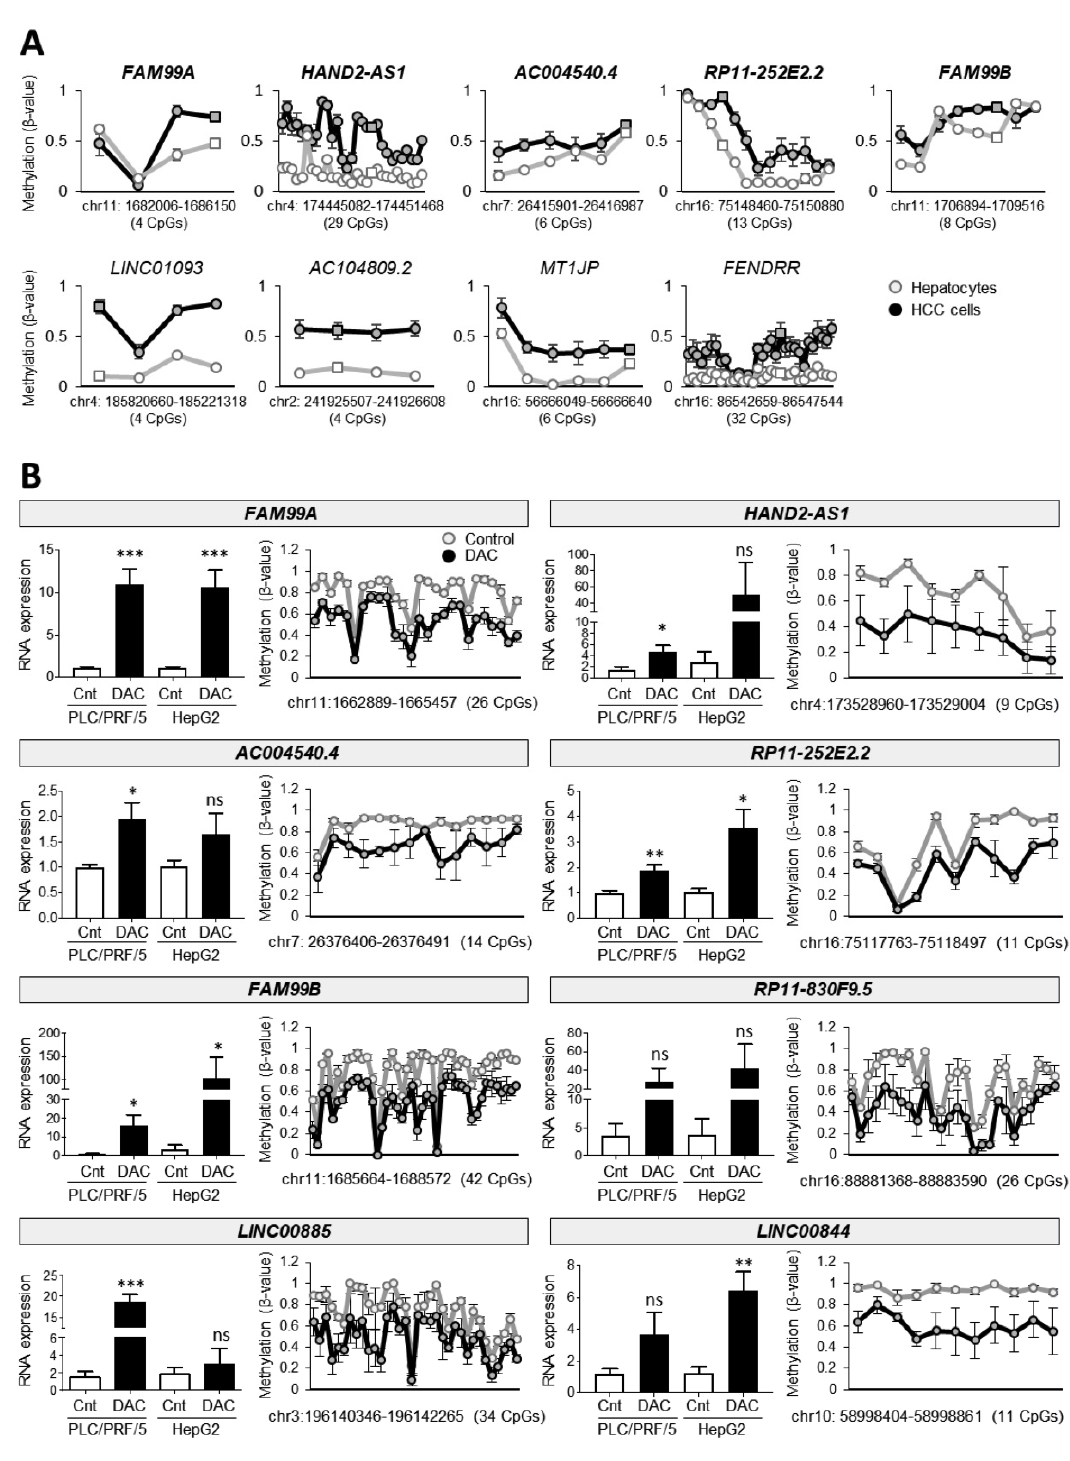
Figure 3. Evaluation of promoter DNA methylation levels of lncRNAs within the Top35 LNDH in human HCC cell lines. ( A ) DNA methylation levels ( β -values) in HCC cell lines (n = 9; FLNEO, H801, HCO2, Hep3B, Huh75, LH86, SNU423, SNU449 and HepG2) and primary hepatocytes (n = 17) from GSE60753, of the CpGs analyzed by the HM450K array within the promoter region of the nine lncRNAs found hypermethylated in human HCC tissues (Figure 2B). The CpGs showed in Figure 2B are indicated as squares. ( B ) For the eight selected lncRNAs, graphs on the left report the